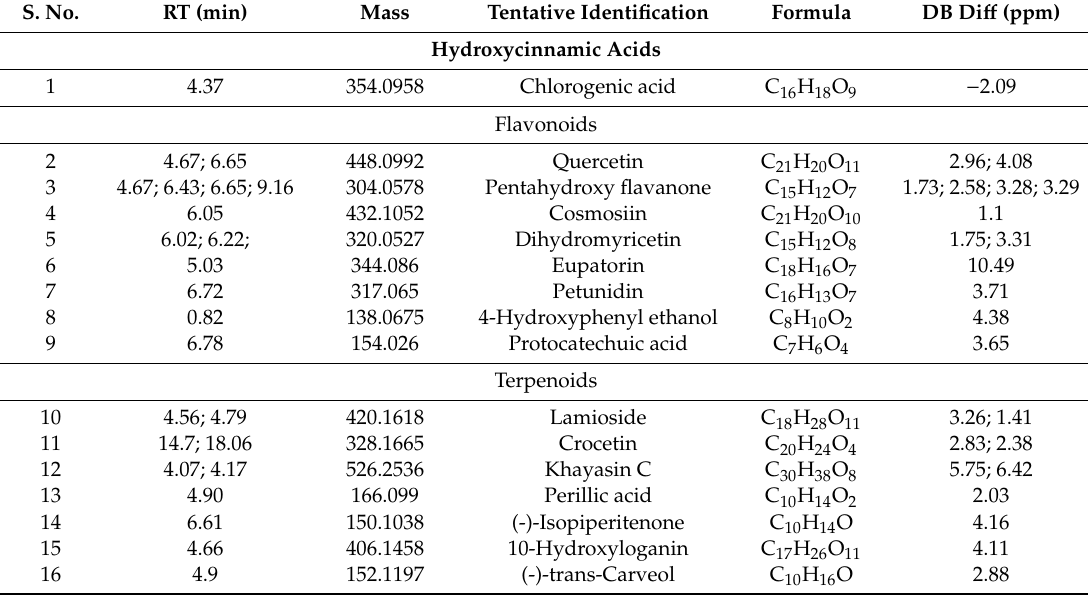
Table 2. Phenolics and other compounds were identified in Ammannia baccifera ethanol extract by using